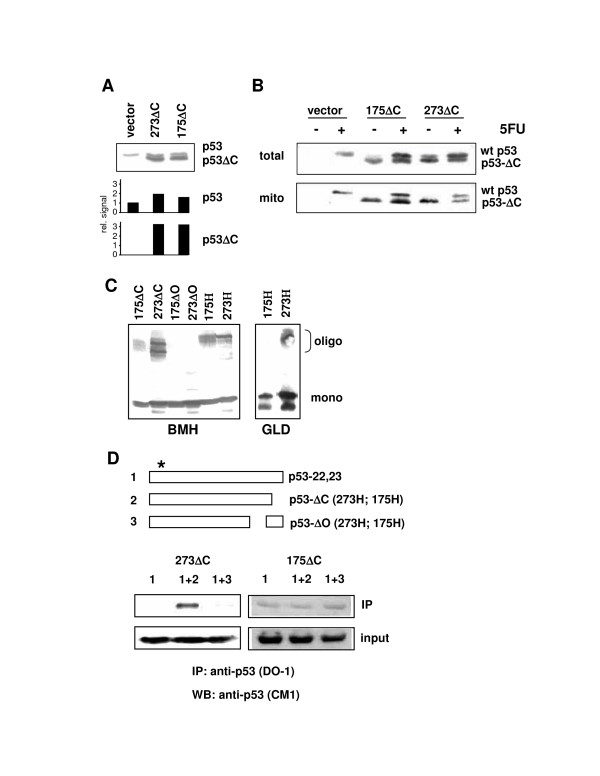
Expression, mitochondrial localization, and oligomerization of mutant p53 proteins. (A) HCT116 cells producing endogenous wt p53 were infected with retroviruses to express, from single gene copies per cell, either empty vector or C-terminally truncated 175H and 273H mutants (175ΔC, 273ΔC). p53 was detected with antibody DO-1 (1:2000) applied to 15 μg of total cell extract. The diagram shows the intensities of the signals produced by wt p53 and the truncated proteins, determined by densitometry and with the signal from wt p53 in vector-infected control cells arbitrarily set as one. (B) Western immunoblot analysis with anti-p53 antibody DO-1 (1:2000) on total and mitochondrial protein prepared at 24 h after the treatment of the three cell lines with 5FU (375 μM) or not. (C) Detection of mutant p53 oligomers in HCT116 p53-/- cells designed to express, again from single gene copies, one of the indicated mutants. The ΔO-mutants carry a deletion in the oligomerization domain. Exponentially growing cells were subjected to crosslinking by either bis-maleimidohexane (BMH) or glutaraldehyde (GLD), as specified in Materials and methods. Oligomers were detected by anti-p53 antibody DO-1 (1:2000) in 15 μg total protein samples that were run on standard SDS-PAGE. (D) Hetero-oligomerization between mutant p53 and a full-length p53 with mutated DO-1 epitope (asterisk). HCT116 p53-/- cells were transiently transfected with expression plasmids producing either construct 1 (p53-22,23) plus no protein (empty vector), construct 1 plus construct 2 (mutants 273H or 175H, with truncated C-terminus), or construct 1 plus construct 3 (mutants 273H or 175H, with deleted oligomerization domain). The deletion mutants were immunoprecipitated with antibody DO-1, and could co-immunoprecipitate p53-22,23 only through hetero-oligomerization. p53 was detected in immunoblots with the polyclonal anti-p53 antibody CM-1 (1:500).